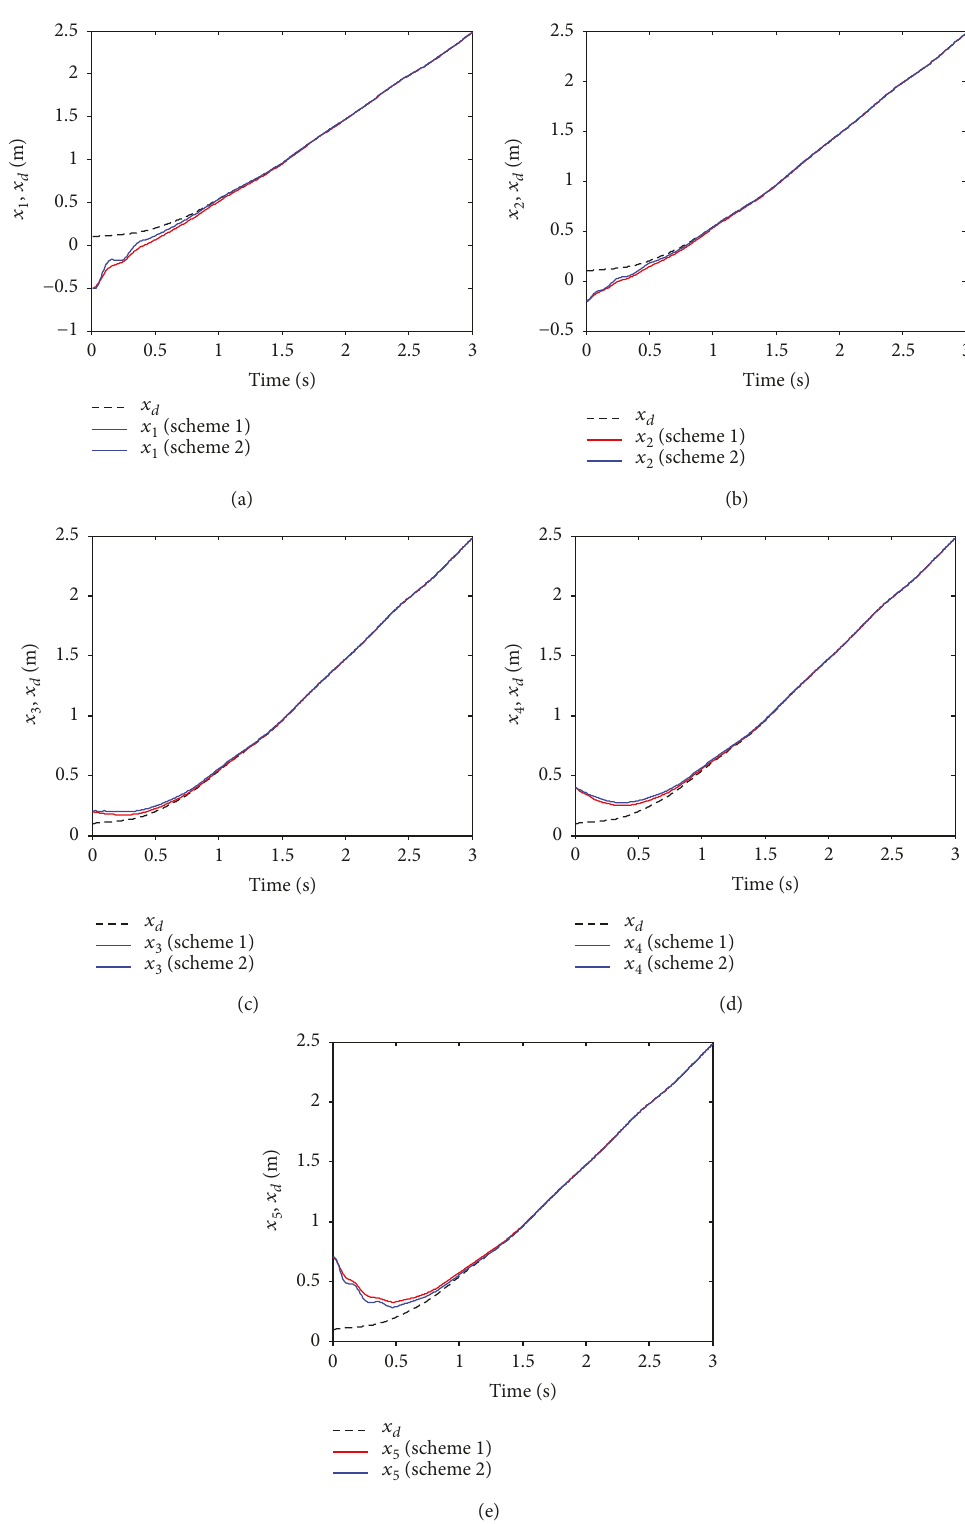
Figure 6: Position tracking